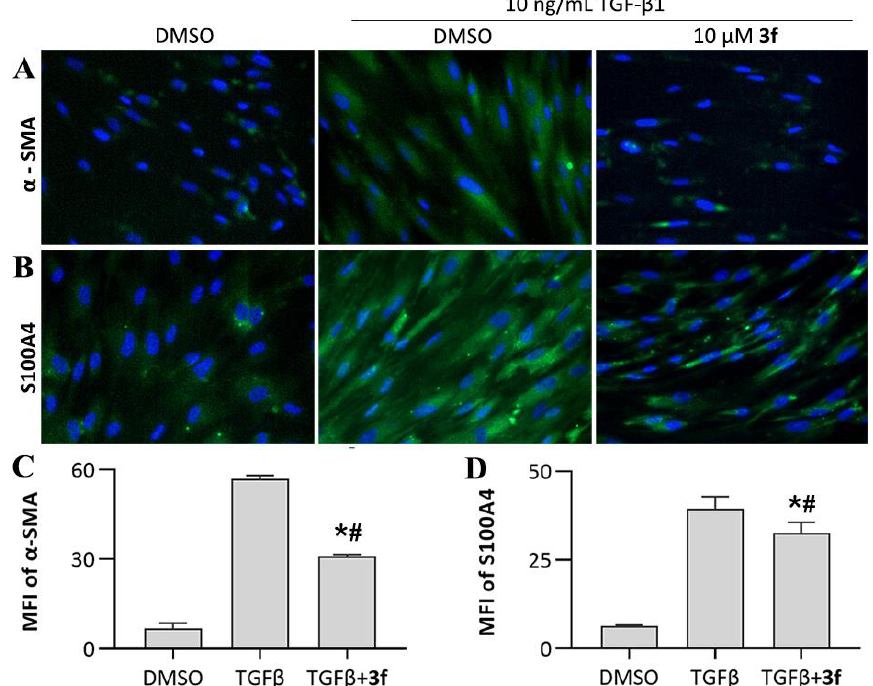
Figure 5. Effects of compound 3f on inhibiting fibroblast-to-myofibroblast transition. ( A , B ) Immunofluorescence staining of myofibroblast markers; ( C , D ) Mean fluorescence intensity of myofibroblast markers, presented as mean ± SD of three individual experiments. * p < 0.05 vs. TGF β group, # p < 0.05 vs. DMSO group.